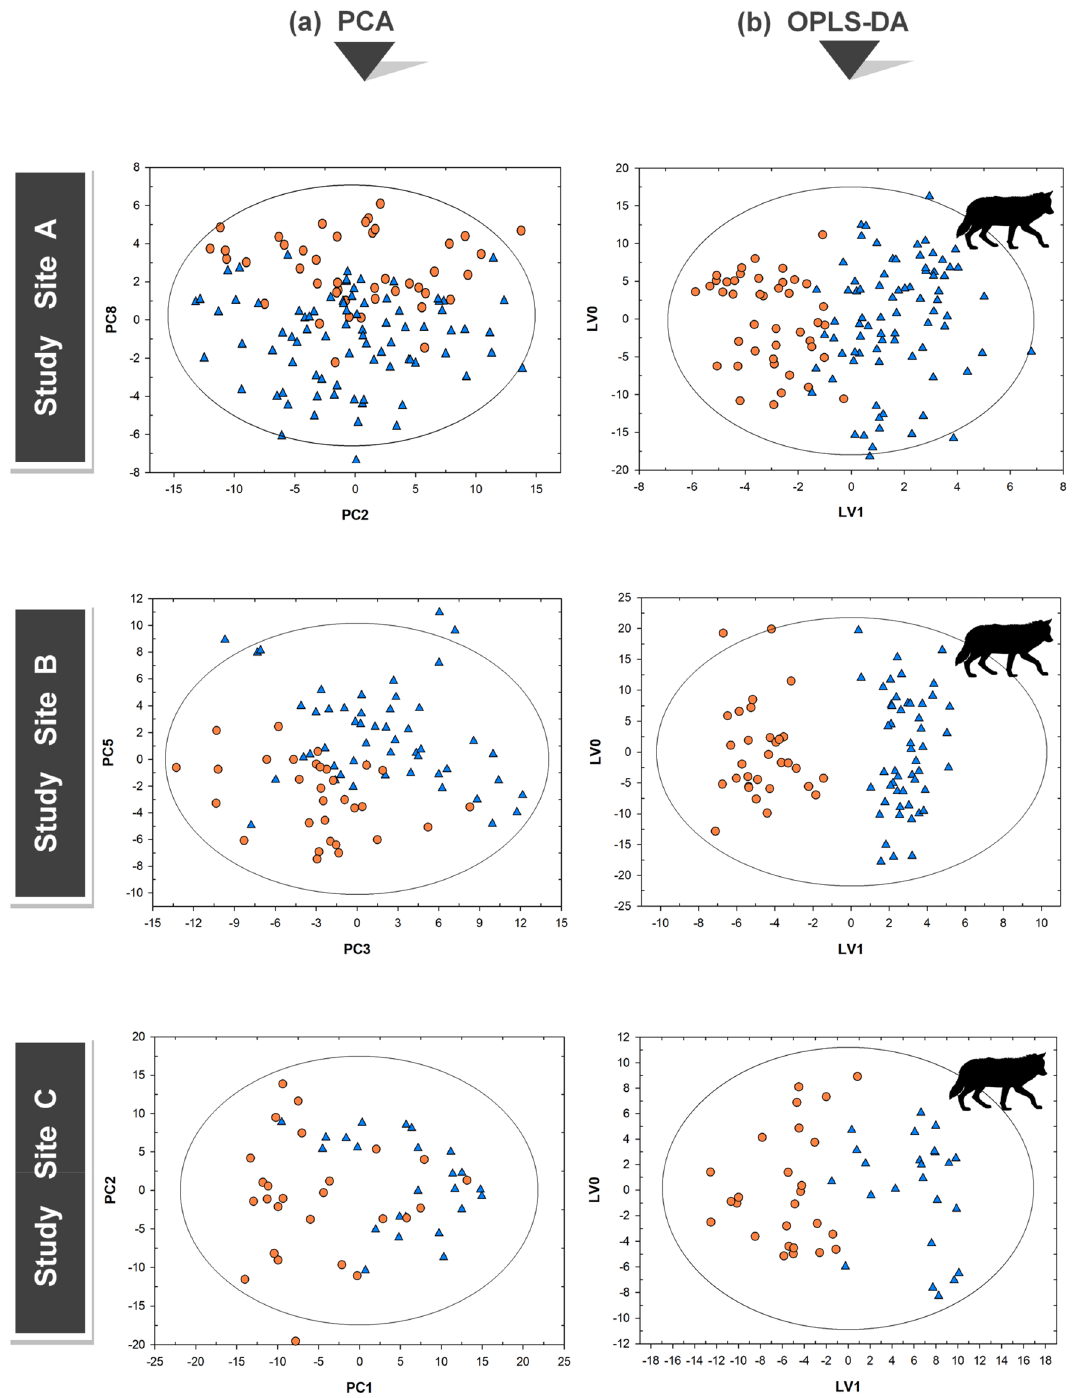
Figure 3. ( a , b ). Metabolic differences of cow fecal extracts in the three sites. ( a ) PCA score plots of 1 H-NMR spectra of cow fecal extracts obtained from samples collected in lower (orange circles) and higher (blue triangle) wolf-impacted areas within each site. The differences between the specific pairs of fecal extracts were statistically significant: in site A on PC2 ( P = 0.024), PC4 ( P = 0.030) and PC8 ( P < 0.0001); in site B on PC3 ( P < 0.0001), PC5 ( P < 0.0001), PC7 ( P = 0.037) and PC8 ( P = 0.031); in site C on PC1 ( P < 0.0001). ( b ) OPLS-DA score plots showing the maximized discrimination between the 1 H-NMR spectra of cow fecal extracts obtained from samples collected in lower (orange circles) and higher (blue circles) wolf-impacted areas within each site. The differences between the specific pairs of fecal extracts were statistically significant ( t -test, P < 0.00001) in all three sites. Plots were produced in SIMCA-P + v.13.0.3 (Umetrics AB, Umeå, Sweden). Abode Illustrator CC (2015) was used to combine the plots into one figure and to create the wolf